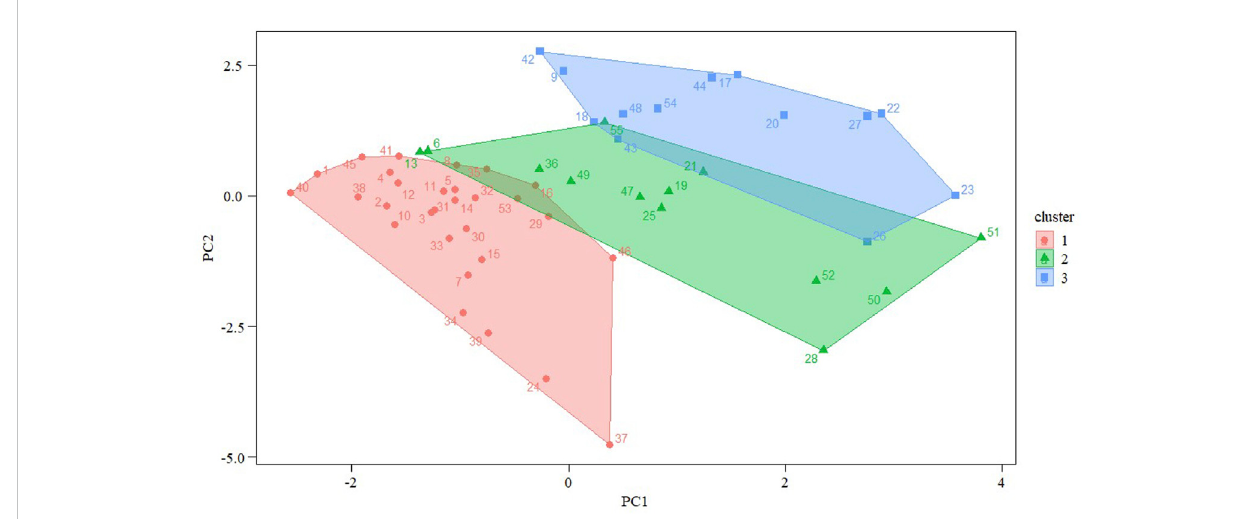
FIGURE 6 PAM clustering effect.